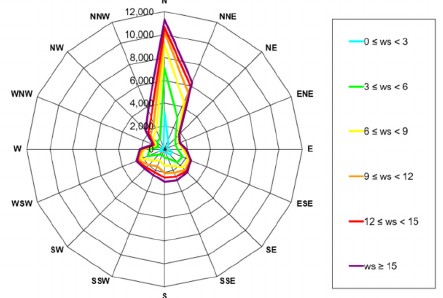
Figure 5. Actual wind direction at 2.3 MW plant in Yeonggwang Baeksu wind farm.